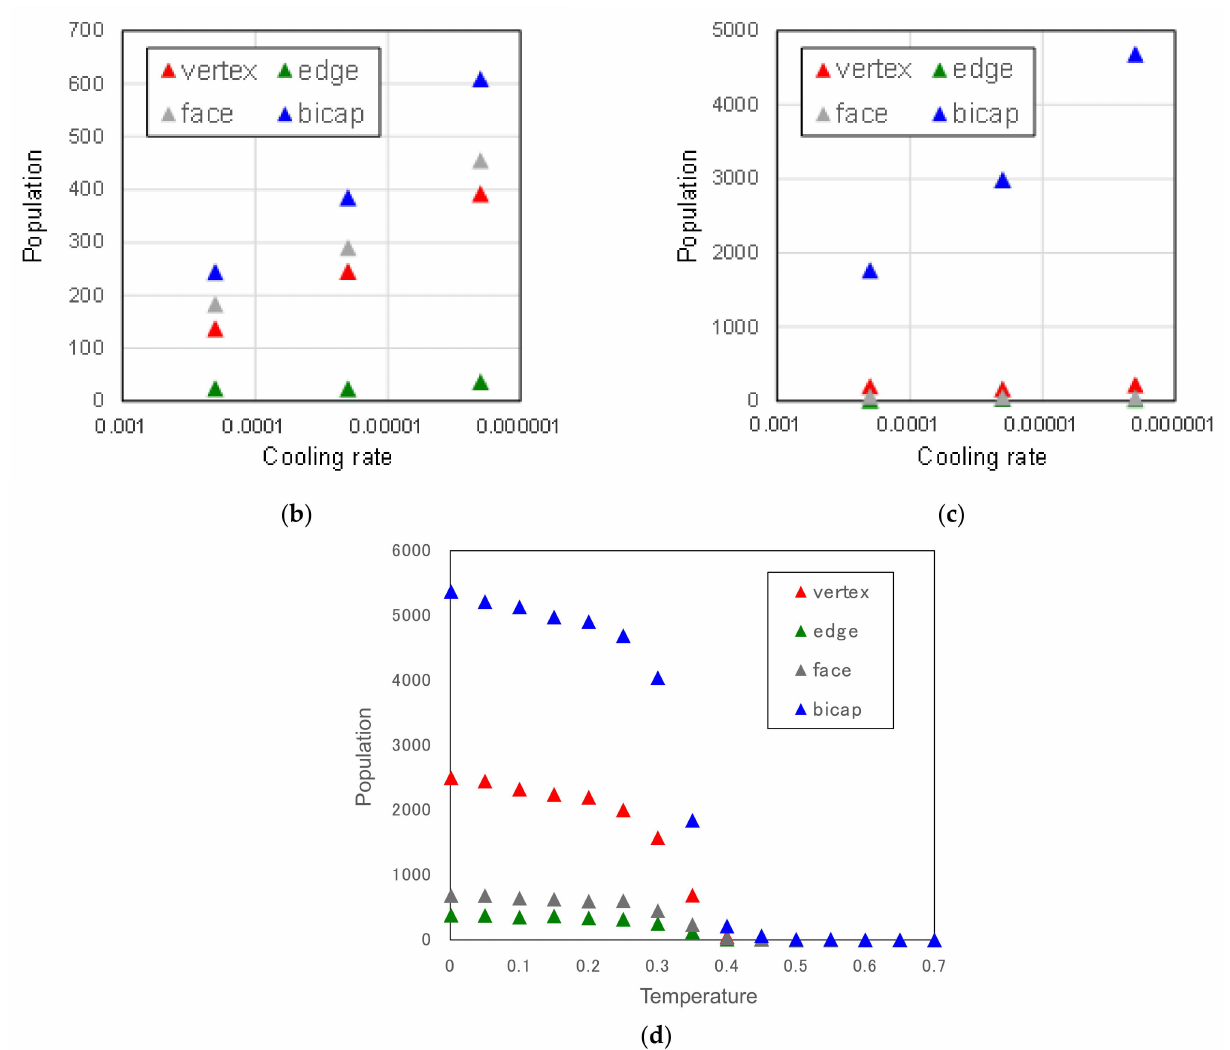
Figure 7. Possible linking patterns between I- or Z-clusters (insets), where the sharing atoms are denoted by grey spheres, and the dependence of their population in the r BB = 0.8 A 50 B 50 glassy phase on the cooling rate: ( a ) Between I-clusters, ( b ) between Z-clusters, and ( c ) between I- and Z-clusters, and ( d ) temperature dependence of the population in a middle- cooling process for the r BB = 0.8 A 50 B 50